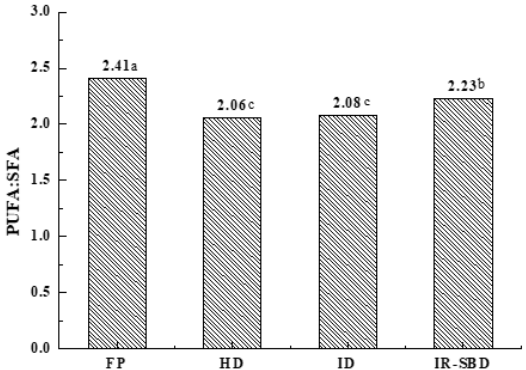
Figure 9. Comparison of the PUFA: SFA ratios to those of untreated fresh whole peanuts. Different letters indicate significant differences ( p < 0.05).